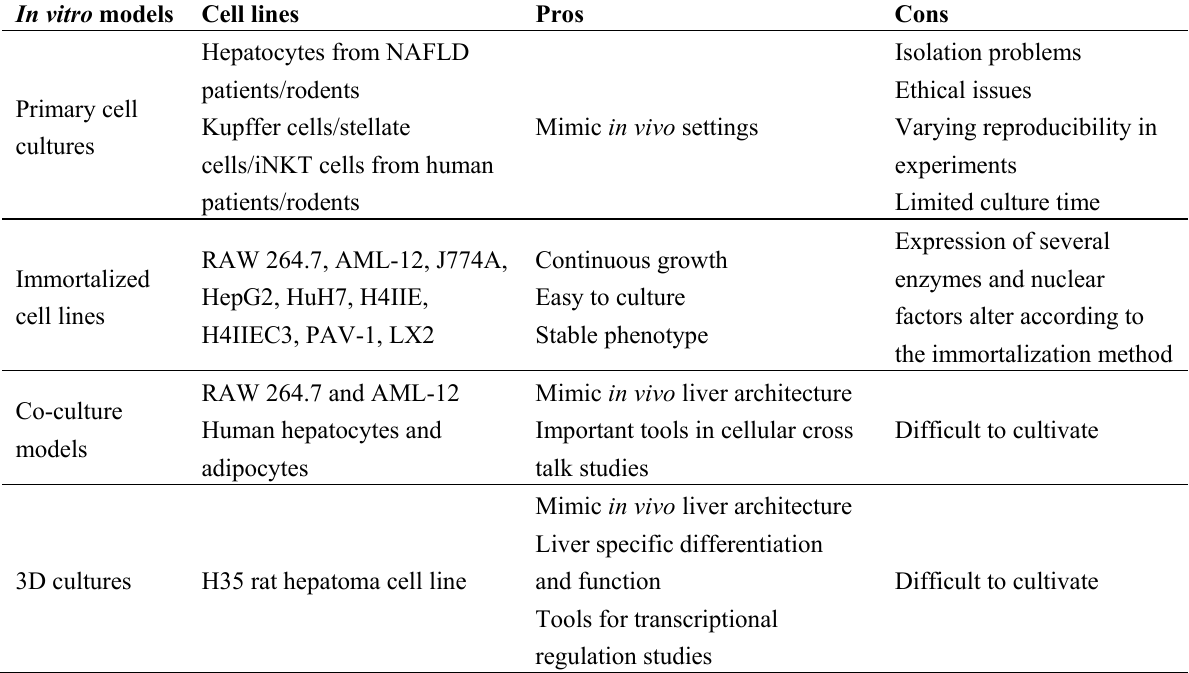
Table 3. Summary of available cell lines and cell culture models